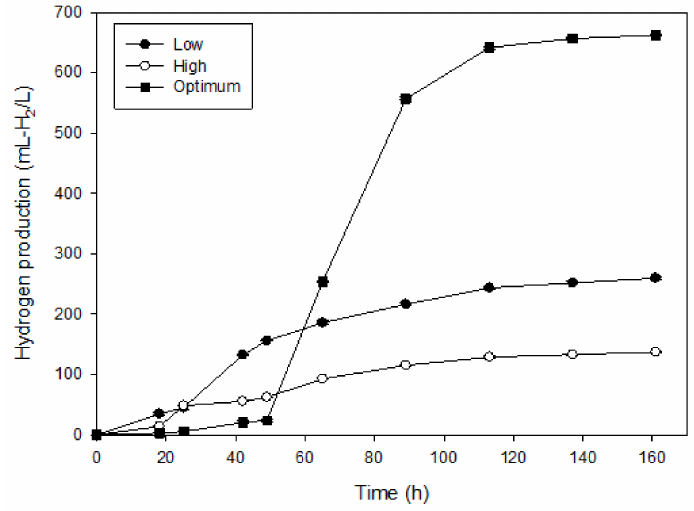
Figure 2. Time course profile of hydrogen production from a codigestion of crude glycerol with algal biomass at the initial pH of 6 at low (10 g/L of glycerol, 6.17% of inoculum, and 4.62 g-VS/L of algal biomass), high (40 g/L of glycerol, 25% of inoculum, and 23.1 g-VS/L of algal biomass), and optimal (13.83 g/L of glycerol, 10.31% of inoculum, and 23.1 g-VS/L of algal biomass) conditions.